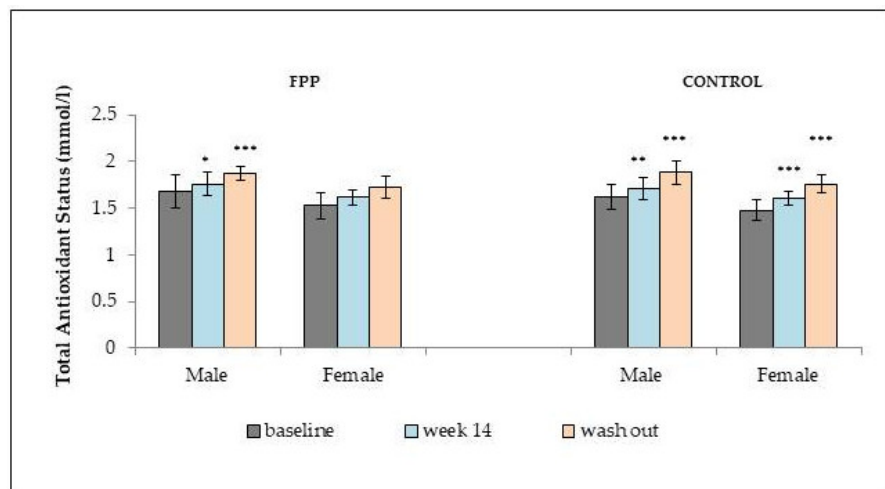
Figure 1. Effect of the total antioxidant (TAS) status in a pre-diabetic population under the FPP ( N = 36) and control regimes ( N = 53). Data is expressed as mean TAS value (mmol/L), where error bars represent standard deviation. * p < 0.05, ** p < 0.01, *** p < 0.001 vs. baseline. Reproduced with permission from Somanah et al. [33], Journal of Preventive Medicine; published by Elsevier, 2012.